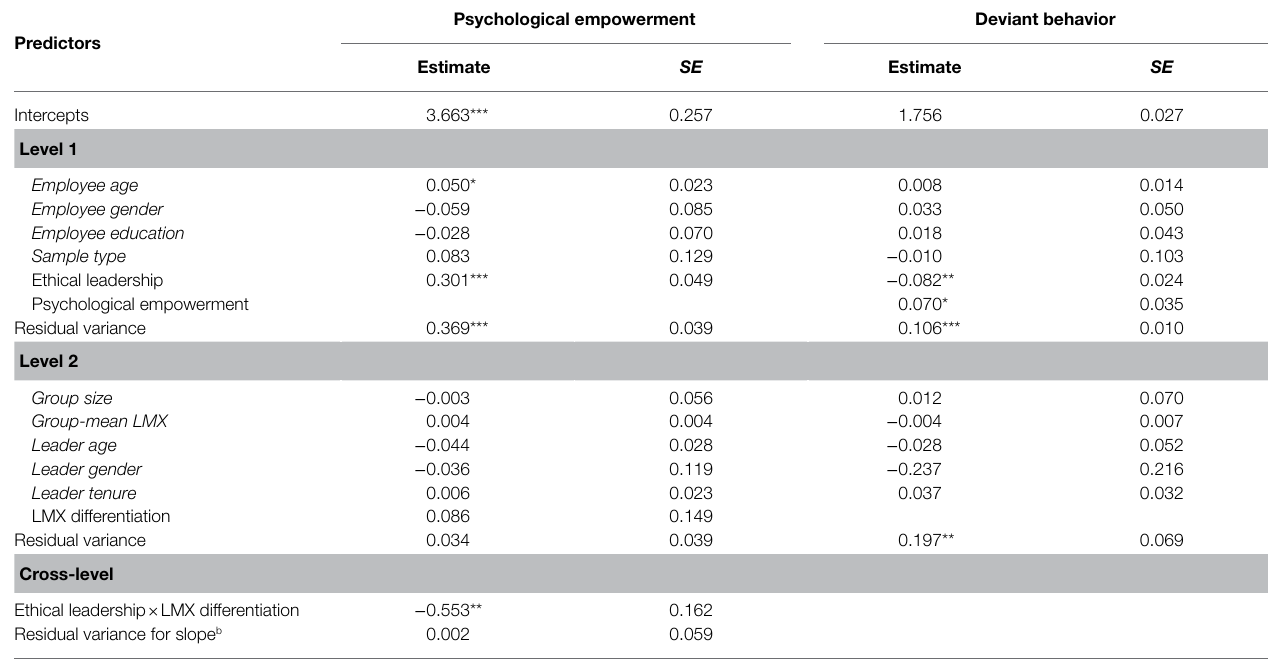
TABLE 3 | Results of path analysis for Model 2 (multi-level moderated mediation